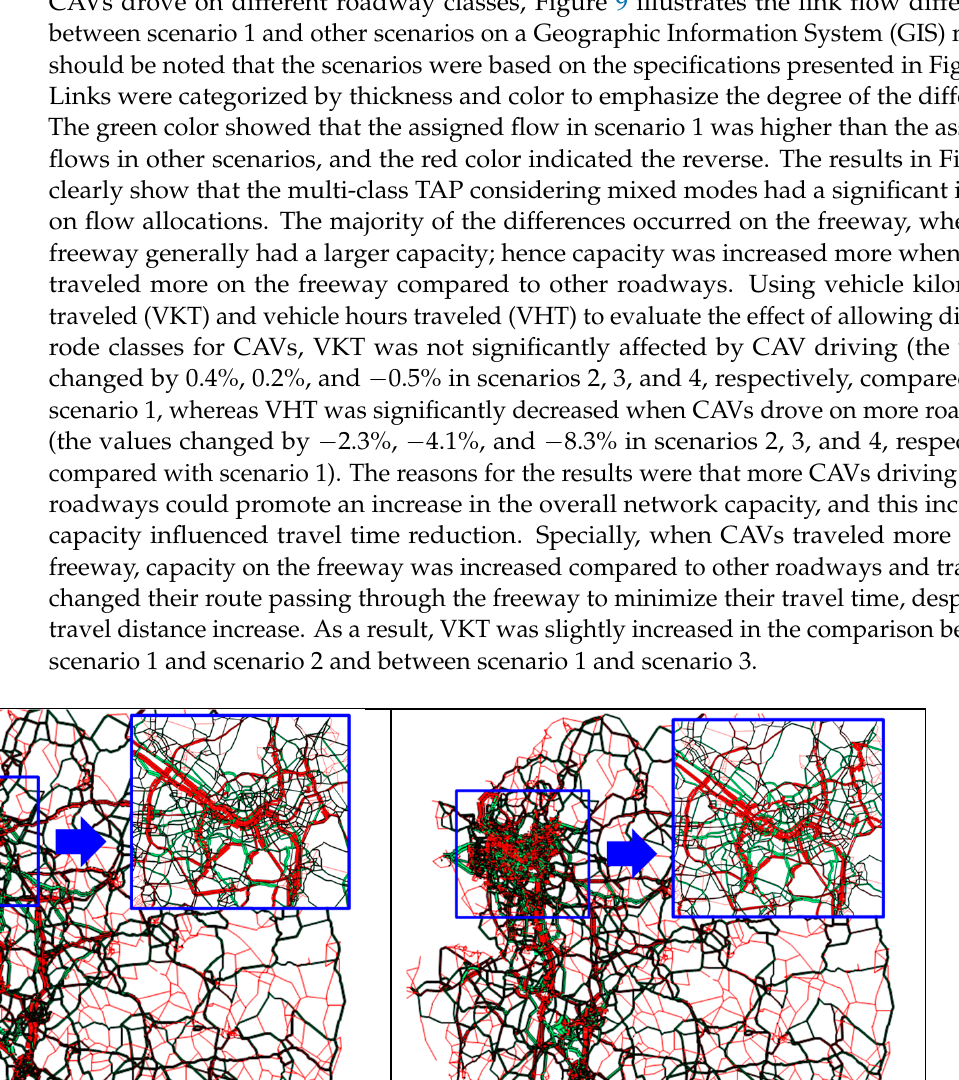
Figure 8. Convergence characteristics.